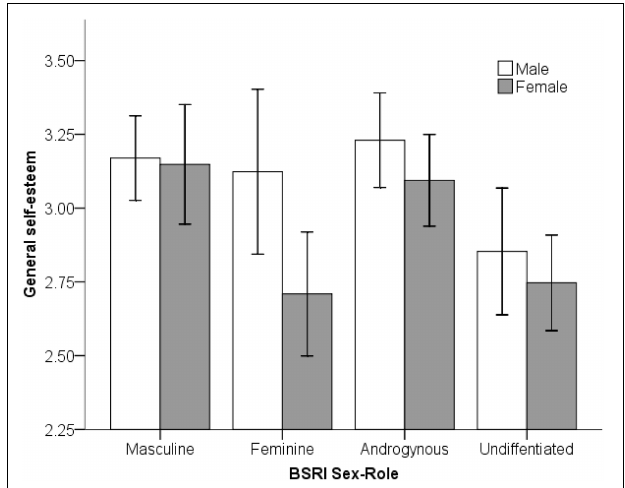
FIGURE 4 | Rosenberg General Self-Esteem scores across gender and sex-role categories (error bars represent the standard error of the